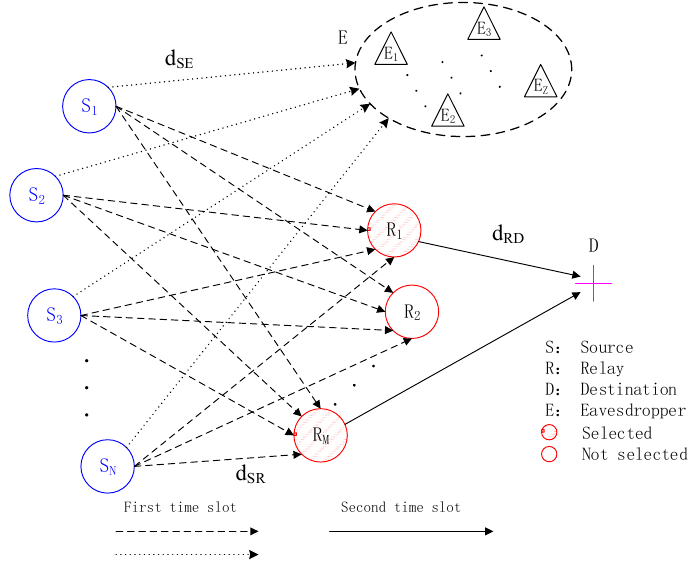
Figure 1. CCS-AF model with eavesdroppers.